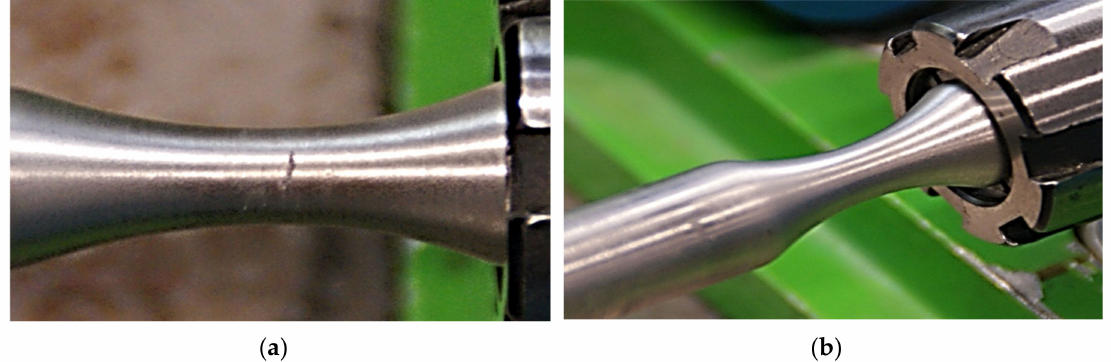
Figure 28. The consequence of friction on the material volume during the test: ( a ) the filings on the surface; ( b ) the specimen after removing the